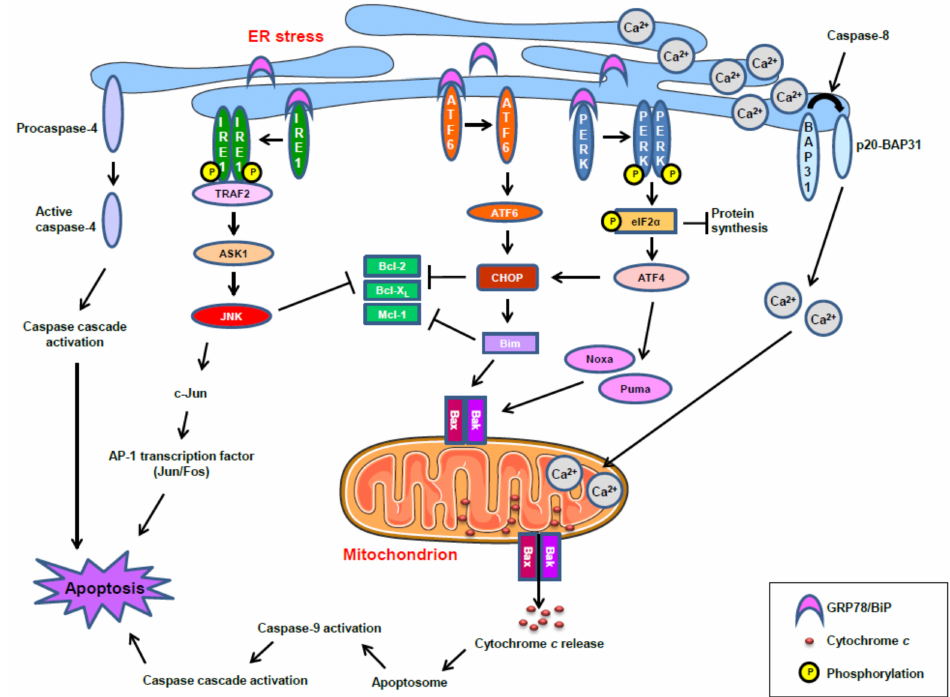
Figure 4. Persistent ER stress-induced apoptosis. Following a sustained ER stress, all three ER stress sensors (IRE1, ATF6, and PERK) activate a series of signaling events depicted in this scheme, involving transcriptional and post-translational modifications, which eventually lead to apoptotic cell death. A crosstalk between the ER and mitochondria is critical for cell demise. Most, if not all, of the signals converge in the mitochondria, before triggering the final cell death response. Additional processes involving BAP31-mediated Ca 2+ release from the ER to the mitochondria, and the activation of caspase 4, also play major roles in the onset of the apoptotic response. See text for